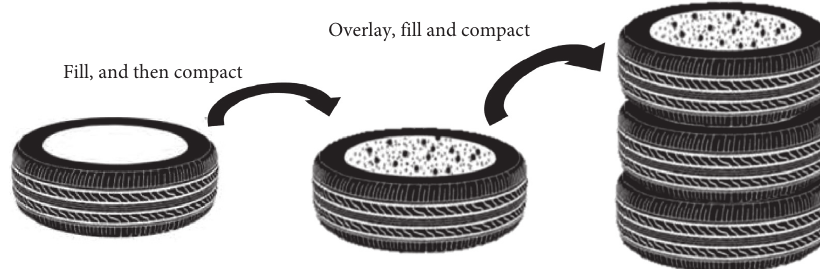
Figure 8: Solid structure of tires.